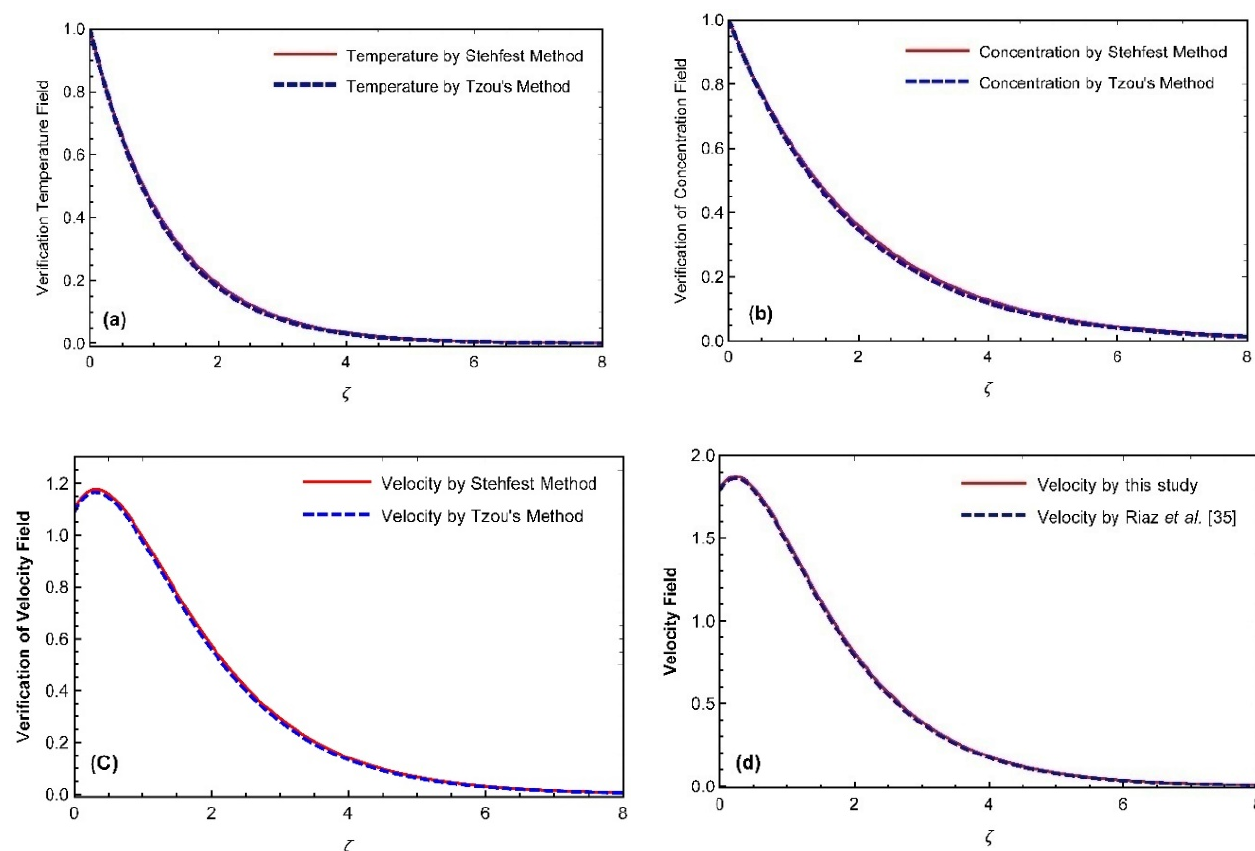
Figure 2. Temperature for fractional parameters with Pr = 5.4, ϕ = 0.02 at ( a ) t = 0.5, ( b ) t = 1.5, ( c ) t = 0.5 and ( d ) t = 1.5 .